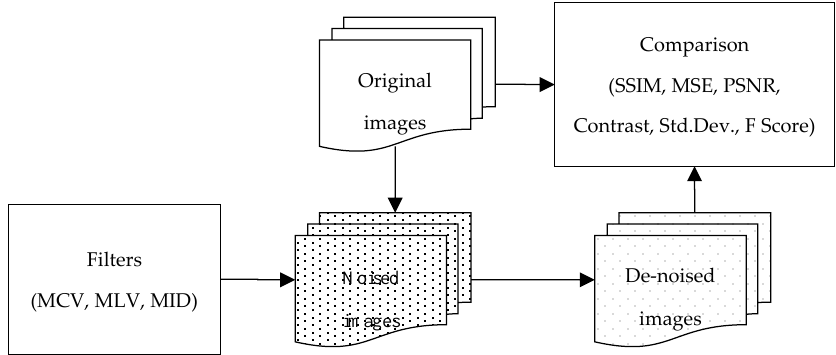
Figure 1. Procedural steps for overall comparisons.